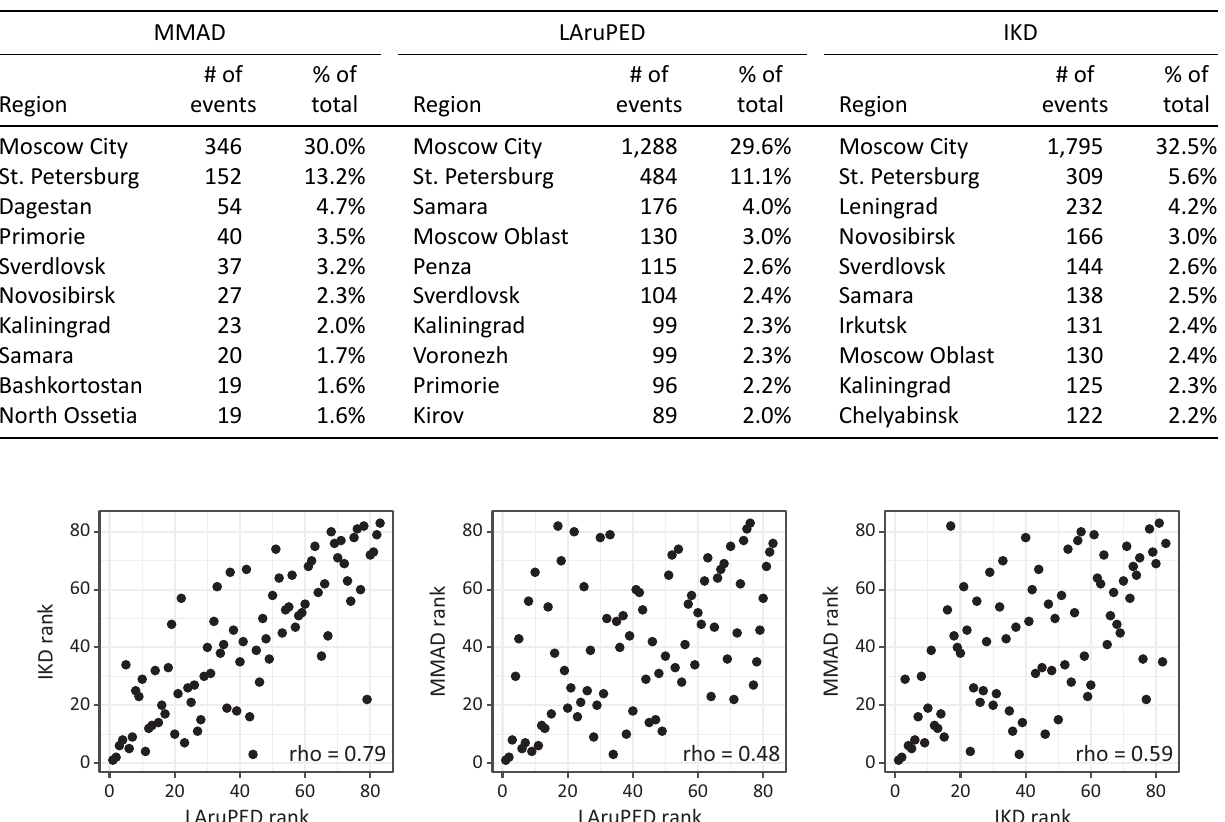
Figure 3. Rank correlations of the number of covered protest events per region, by combination of data sets (March 2007–March